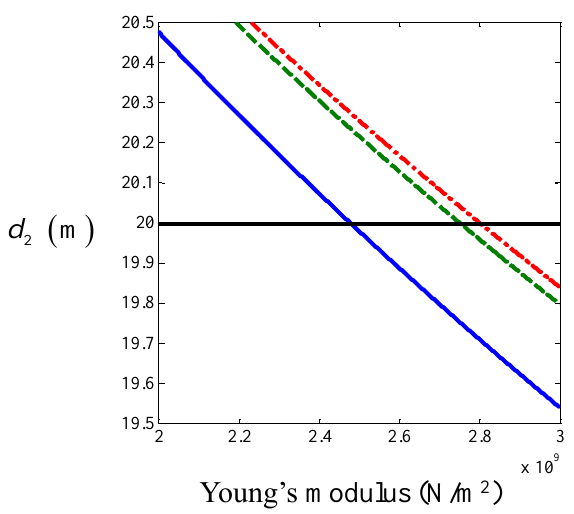
Figure 7. Estimate of the leak position as a function of the Young’s modulus of the pipe calculated using different types of sensors. solid blue line, hydrophone; dotted green line, geophone; dashed red line,